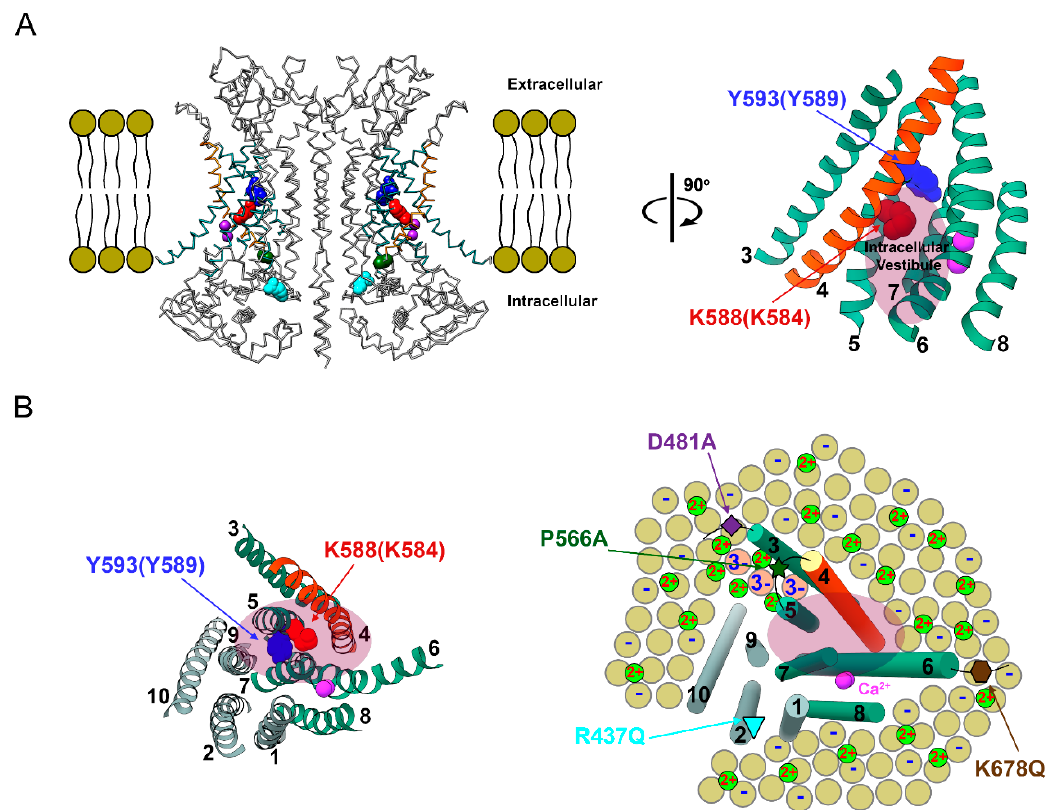
Figure 11. Illustration of divalent cation effects on TMEM16 molecules. ( A ) High resolution structure of the “ac” alternatively spliced variant of TMEM16A (left, PDB:5OYB). The six transmembrane helices (helices 3–8) of a single subunit forming the ion-conduction pathway are rotated 90° clockwise along the axis perpendicular to the cell membrane (right). Helix 4 is colored in orange, whereas all other helices are colored in green. Residue K584 of the alternatively spliced “a” variant of TMEM16A (used in our experiments) and residue Q559 of TMEM16F corresponds to residue K588 of the TMEM16A “ac” variant (colored in red). Y589 of the TMEM16A “a” variant mentioned in the text corresponds to Y593 in the TMEM16A “ac” variant (colored in blue). Light purple oval roughly depicts the intracellular pore vestibule. ( B ) Intracellular view perpendicular to the cell membrane of a single subunit. (Left) all transmembrane helices (with helix numbers) are shown. (Right) Cartoon model of the six pore-forming helices depicted as cylinders (same orientation as that in the left panel). Intracellular leaflet of cell membranes contains negatively charged phospholipids (yellow circles labeled with “ − ”) as well as neutral ones (yellow circles without “ − ”). PIP2 molecules are depicted as salmon-color circles with “3 − ”. The Ca 2+ ions at the activation sites are colored in pink. Monovalent (not shown), divalent (depicted as small green circles) or even multivalent cations (not shown) can bind to phospholipid head groups, consequently decreasing the negative potential from phospholipids. Four mutations associated with PIP2 regulations of TMEM16A studied in this paper are shown. Notice that residues P556 (dark green star) and D481 (purple diamond) appear to be closer to the intracellular pore vestibule than residues R437 (cyan down triangle) and K678 (brown hexagon).